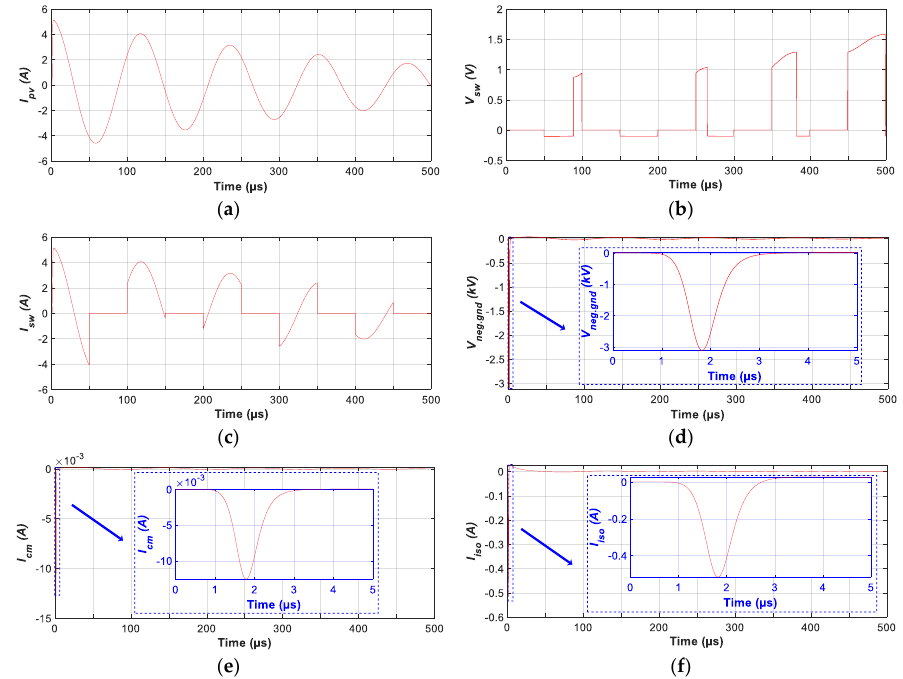
Figure 12. Reference case, voltages and currents induced in some of the remaining components of interface circuitry: ( a ) PV current output; ( b ) switch voltage; ( c ) current across the switch; ( d ) voltage of negative output terminal to ground; ( e ) common mode current; ( f ) module insulation current.